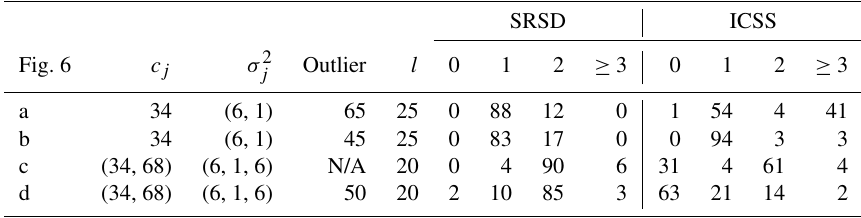
Figure 6. Results of Monte Carlo experiments with an outlier x ∗ Table 5. Table 5. Percentages of total numbers of change points detected by SRSD (0.05, l , 2) and ICSS in each series on average in the case